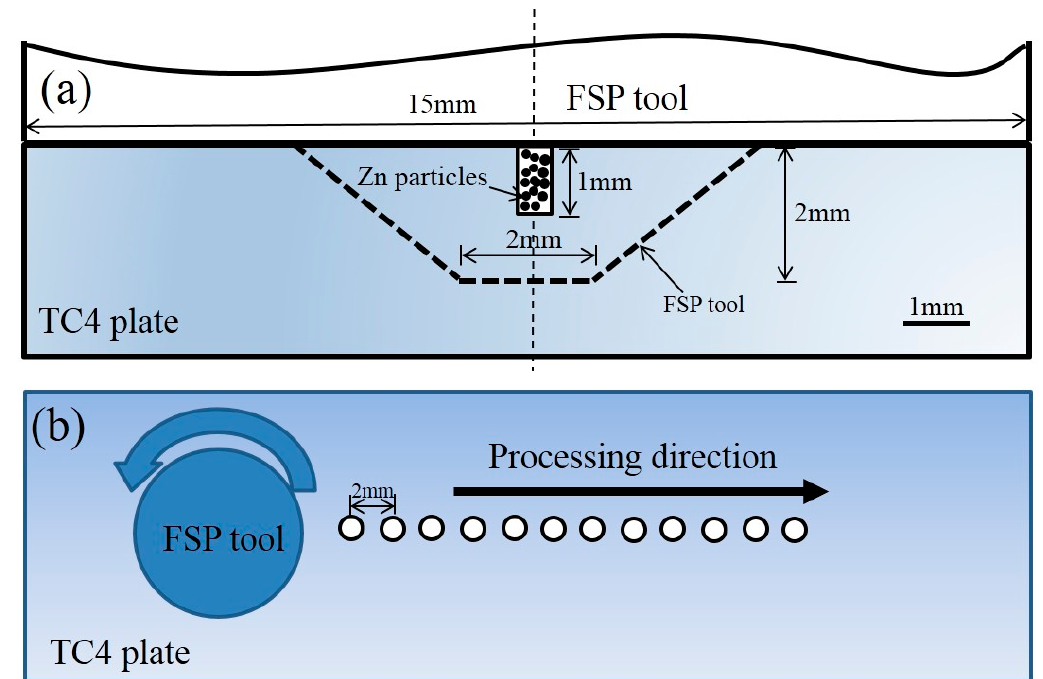
Figure 1. ( a ) Schematic diagrams showing the dimensions of the FSP tool and ( b ) the hole distribution in the TC4 plate.